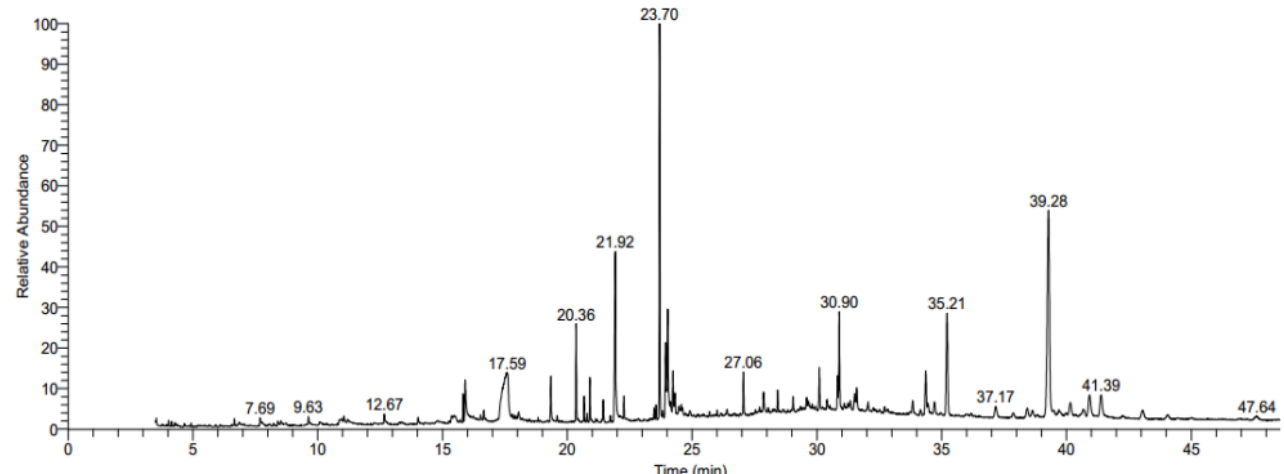
Figure 10. The total ion chromatograms of compounds determined by GC-MS of RLE.